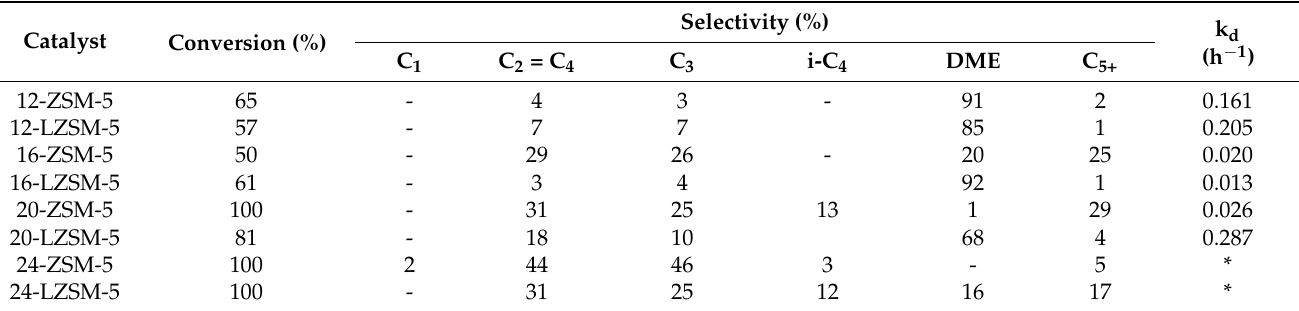
Table 3. Methanol conversion and hydrocarbon selectivity achieved over as-synthesized catalysts during the MTH